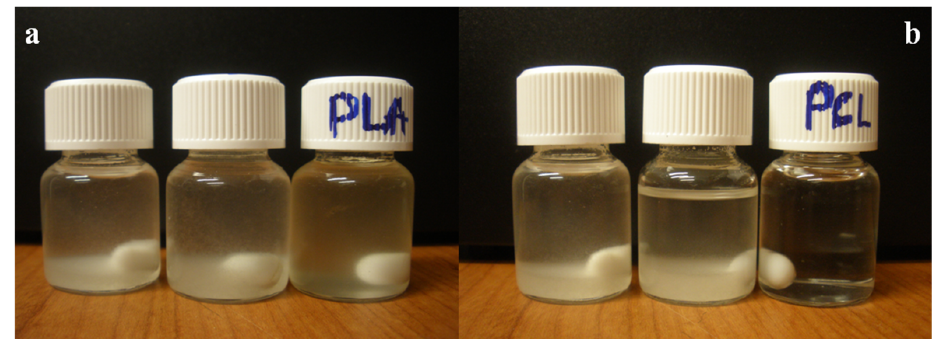
Figure 2. Solutions in chloroform, after 30 min of settling, for (from left to right) pristine cellulose nanocrystals, mixture of cellulose nanocrystals and homopolymer, and grafted cellulose nanocrystals ( a ) with PLLA and ( b ) with